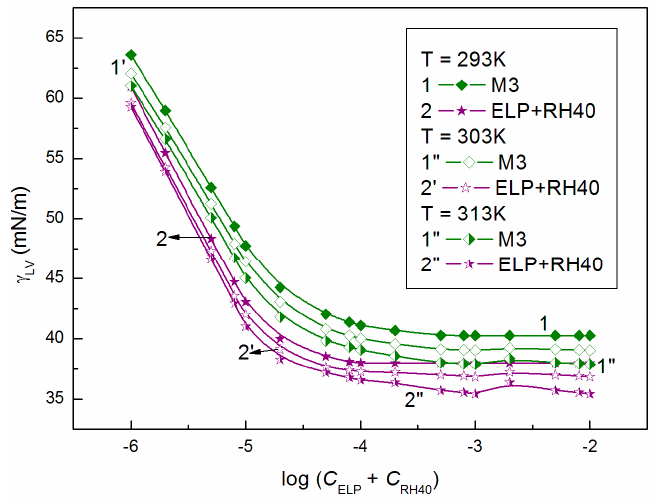
Figure 4. A plot of the surface tension ( γ LV ) of M3 mixture aqueous solutions (curves 1, 1 (cid:48) and 1 (cid:48)(cid:48) ) and ELP + RH40 mixture aqueous solutions at a mole fraction of ELP equal to 0.8 [22] (curves 2, 2 (cid:48) and 2 (cid:48)(cid:48) ) vs. the logarithm of the sum of ELP and RH40 concentration (log (( C ELP + C RH40 )) at a constant temperature equal to 293 K (curves 1 and 2), 303 K (curves 1 (cid:48) and 2 (cid:48) ), and 313 K (curves 1 (cid:48)(cid:48) and 2 (cid:48)(cid:48) ).